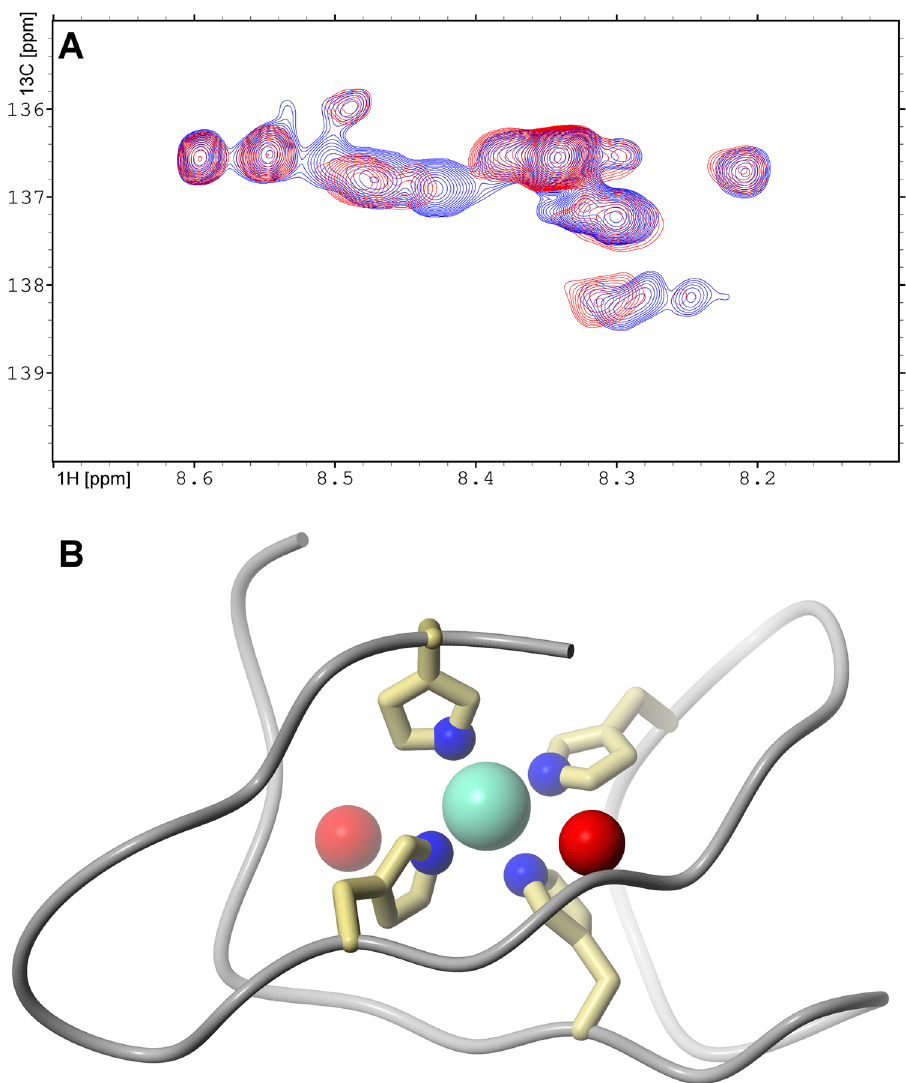
Figure 5. (A) Region of NMR cross-peaks for aromatic hydrogens, from 2D 1 H- 13 C HSQC spectra acquired for 13 C, 15 N-labeled hu PrP C (23–231) protein in apo (blue) and Zn-saturated (red) form; (B) 3D model of the hu PrP C Zn(II)-binding motif, obtained from MD simulations. The histidine nitrogen atoms coordinating the Zn(II) ion are shown in blue. The two additional carbonyl oxygens (Gly71 and Trp89) present in the second coordination shell are shown in